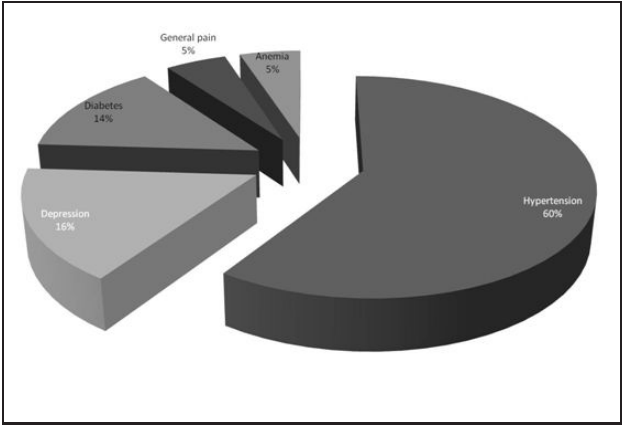
Fig. 3: Distribution of the Unified Health System users according to reported chronic diseases in the city of Pelotas-RS, Brazil.